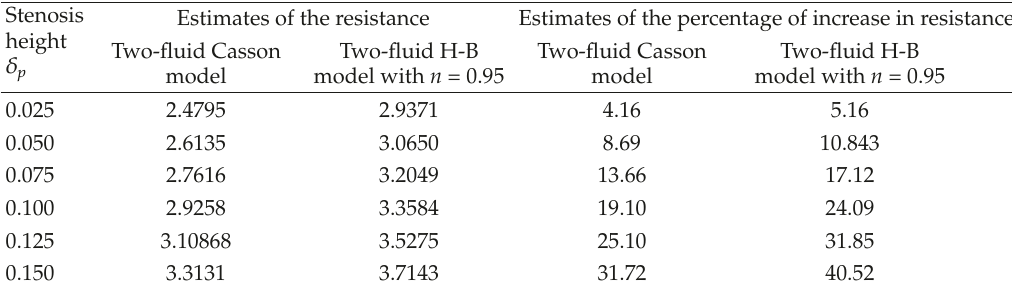
Table 2: Estimates of the resistance and percentage of increase in the resistance to flow (cid:2)Λ(cid:3) of the two-fluid Casson model and two-fluid Herschel-Bulkley model over uniform diameter tube for di ff erent stenosis heights with A (cid:7) α (cid:7) α H (cid:7) 0 . 5 , β (cid:7) 0 . 985 , θ (cid:7) 0 . 1 , and t (cid:7) 45 ◦